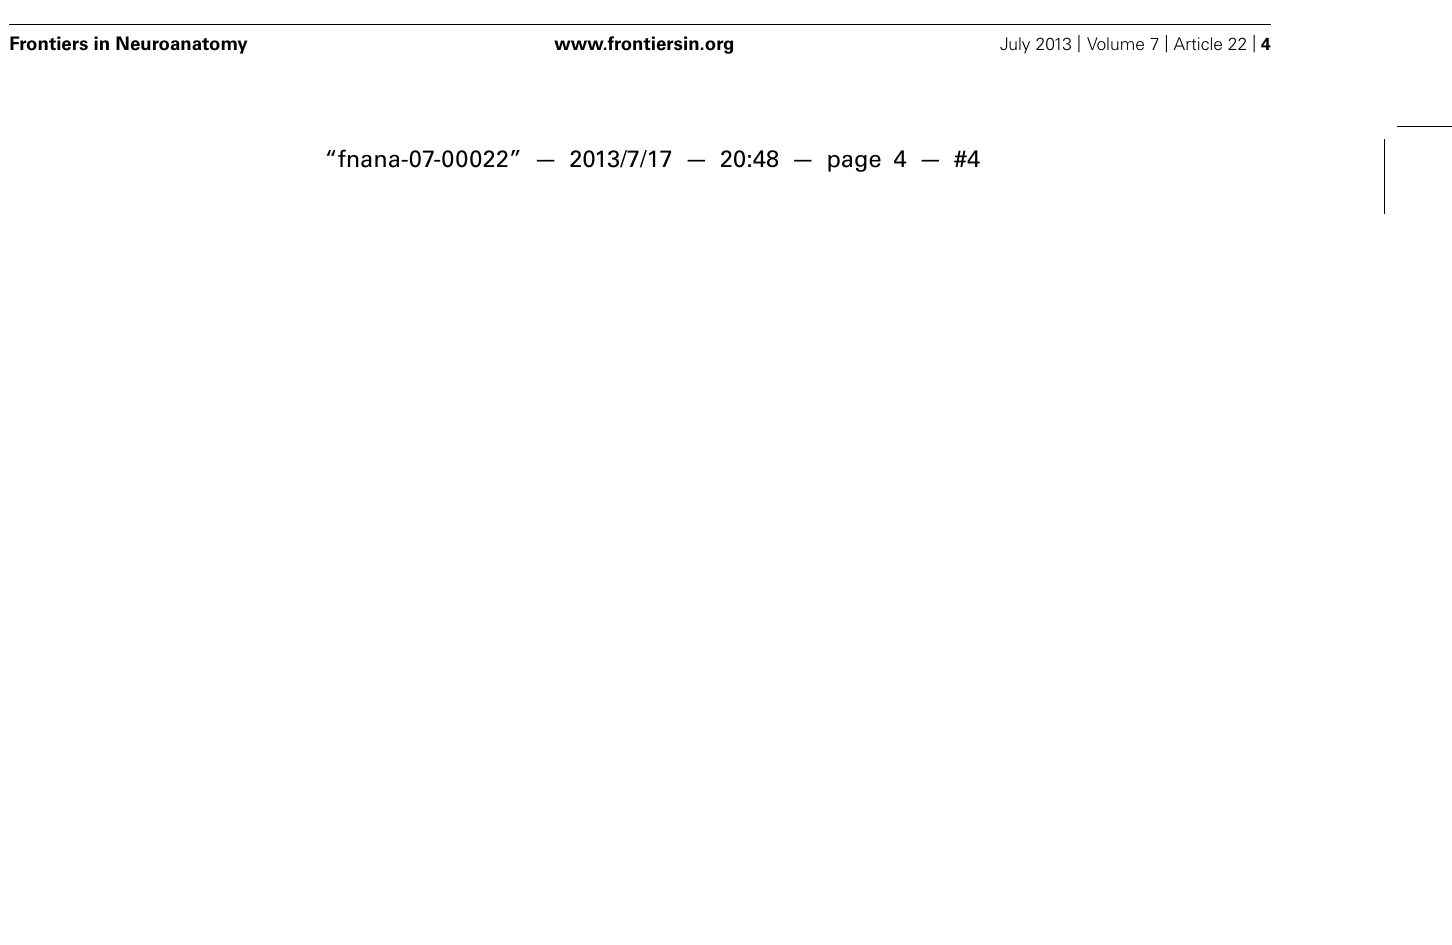
maternal blood. Hemochorial placentation is the most invasive and allows fetal tissues to be bathed directly in the maternal blood. Epitheliochorial and Endotheliochorial placentas can be found in Afrotheria, Euarchontoglires and more frequently in Laurasiatheria. Hemochorial placentas are found in all eutherian superorders (Wildman etal., 2006), showing a broad distribution of placental types in the mammalian